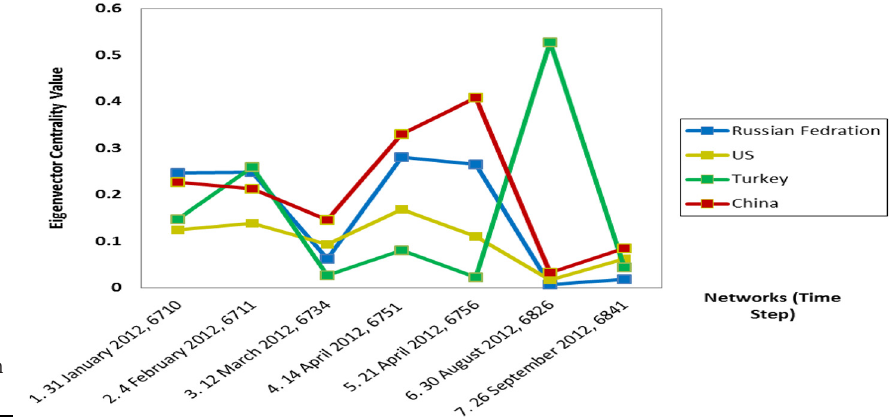
Figure 1. Eigenvector centrality values for the key States